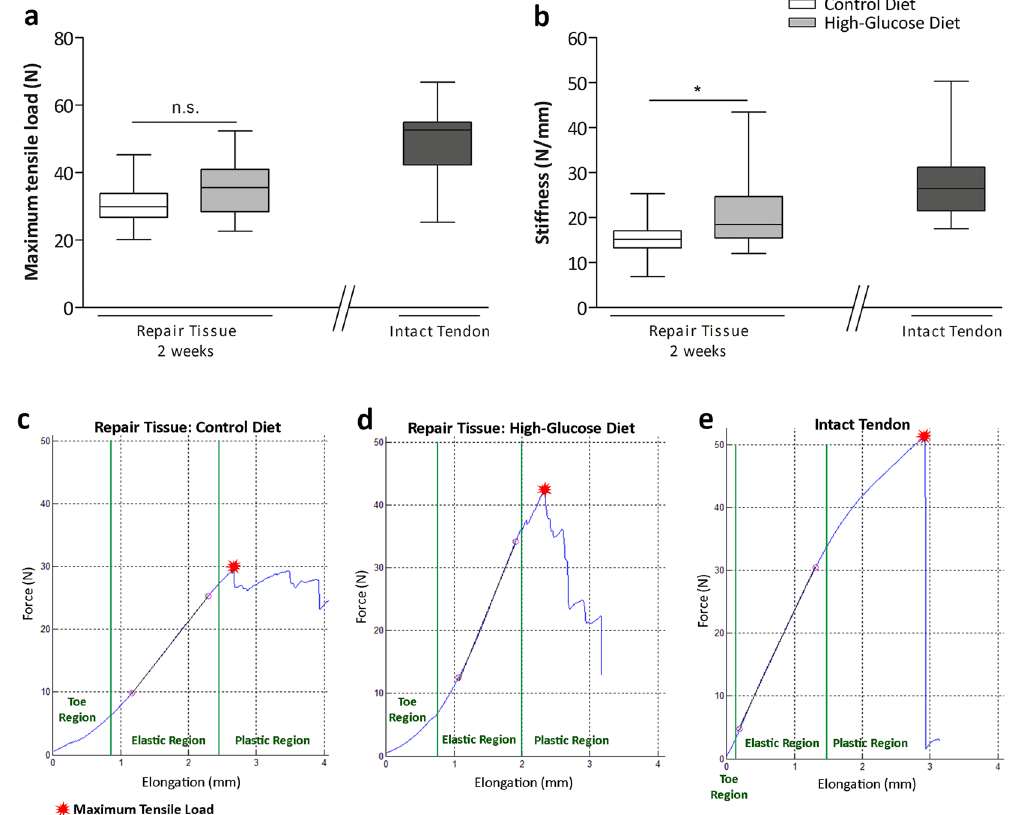
Figure 3. Biomechanical properties of tendon repair tissues 2 weeks after Achilles tenotomy. Biomechanical tests comparing maximum tensile load of the repair tissues 2 weeks after surgery revealed no significant difference (p > 0.05; Mann-Whitney test, two-tailed) between the experimental groups ( a ). Tendon stiffness measurements 2 weeks after surgery among the experimental groups showed significantly stiffer repair tissues (p < 0.05, asterisk; Mann-Whitney test, two-tailed) in the high-glucose group (n = 14) when compared to the control group (n = 14) ( b ). Values for intact tendons are provided as a reference (n = 9). Representative force- elongation diagrams of the repair tissues of the control diet group ( c ), the high-glucose diet group ( d ) and of an intact tendon ( e ). In the toe-region collagen fibres are crimped and become elongated and straightened with applied loading. The linear region represents tendon stiffness. Microscopic tears occur in the plastic region where the slope drops until the maximum tensile load is reached and the tendon